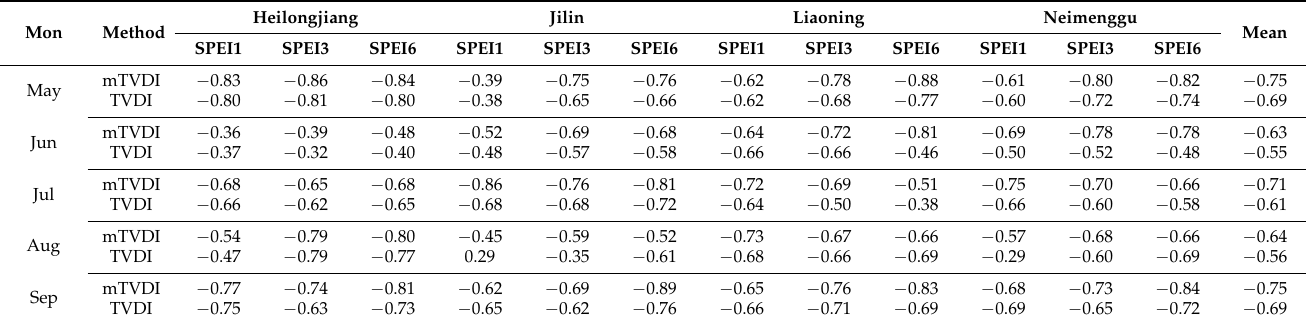
Table 5. Pearson correlation coefficients between the mTVDI, TVDI, and SPEIs.